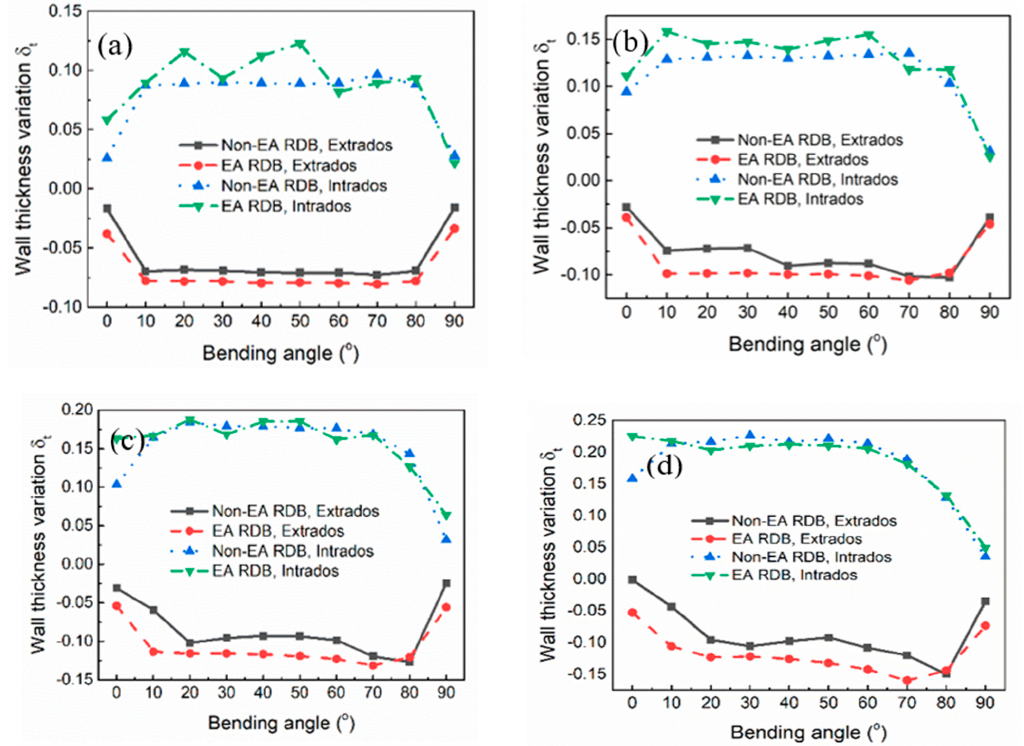
Figure 8. Wall thickness variation at different bending angles in non-EA and EA RDB with 10 mm bending radius of different micro-tube diameters: ( a ) 3 mm, ( b ) 4 mm, ( c ) 5 mm, ( d ) 6 mm.